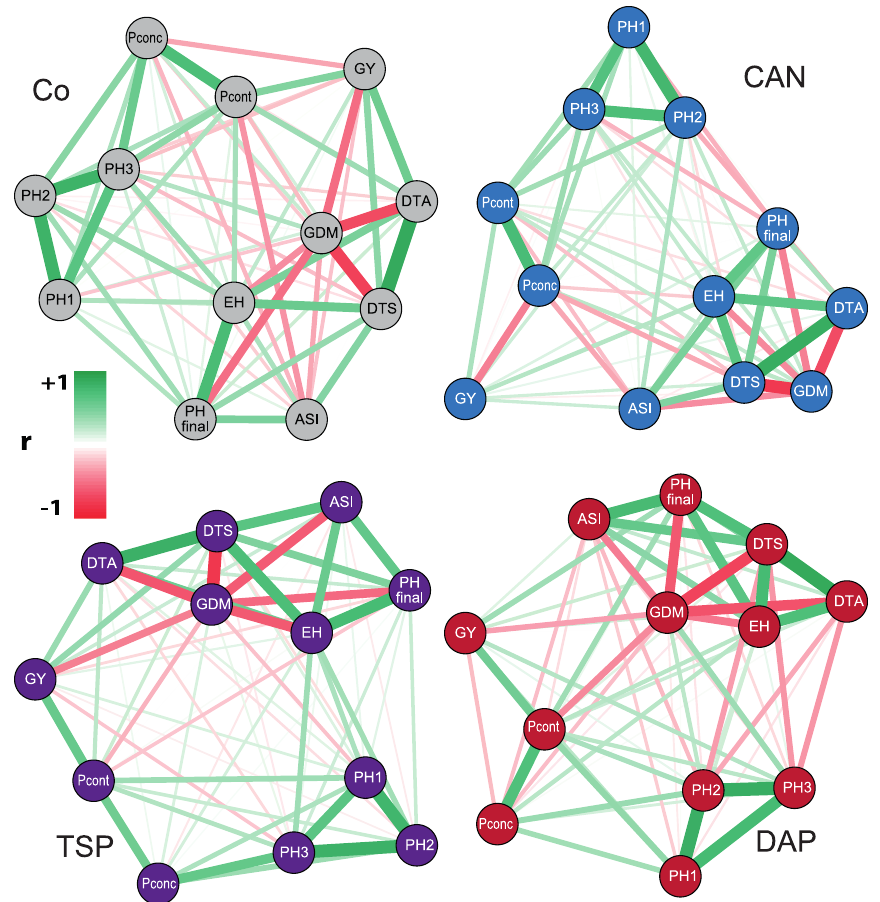
Fig 2. Associations among the investigated traits dependent on the starter fertilizer. Control (Co, grey), triple superphosphate (TSP, purple), calcium ammonium nitrate (CAN, blue), diammonium phosphate (DAP, red). Network plots showing anthesis-silking-interval (ASI), days to anthesis (DTA), days to silking (DTS), ear height (EH), grain dry matter content (GDM), grain yield (GY), P grain concentration (Pconc), P grain content (Pcont), and plant heights (PH1, PH2, PH3, PHfinal). Positive Pearson correlations (r) are indicated in green, negative Pearson correlations in